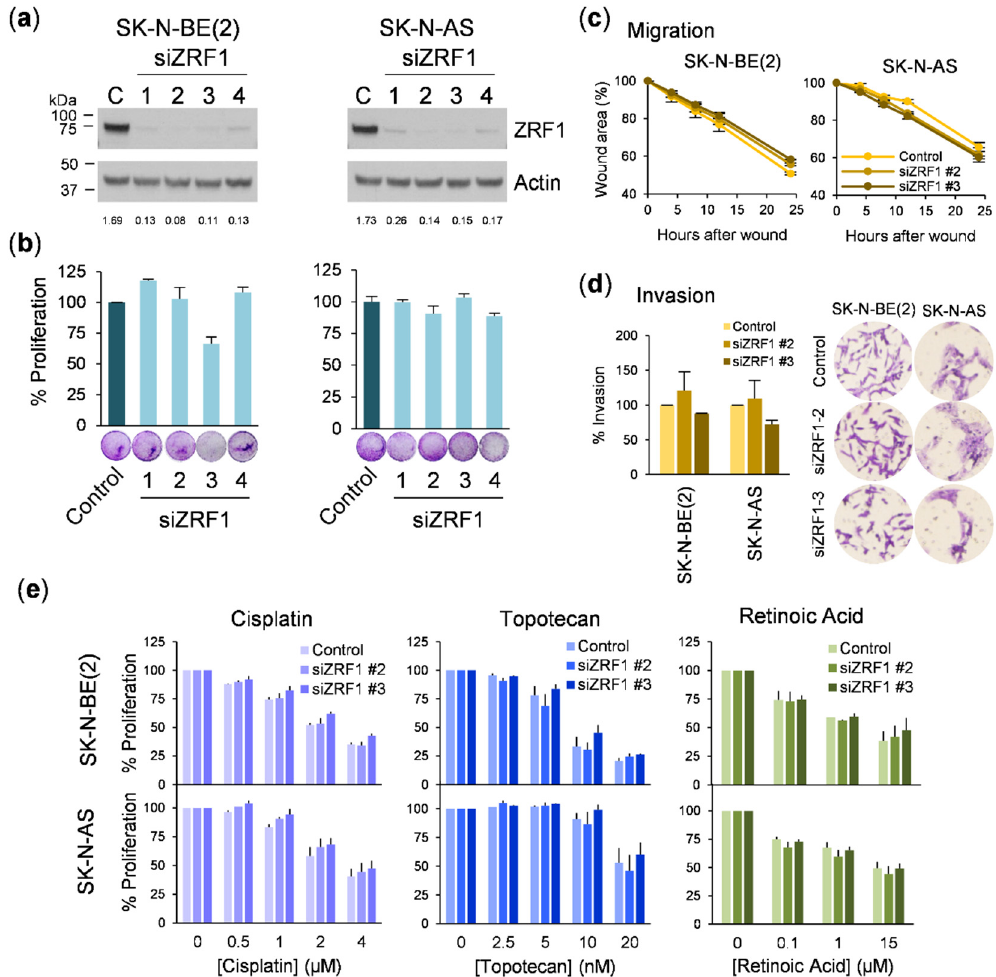
Figure 6. ZRF1 is dispensable for neuroblastoma growth, migration, and drug resistance. ( a ) ZRF1 levels in neuroblastoma cells transfected with siRNA control and 4 different si ZRF1 . Actin-normalized densitometry quantification of ZRF1 levels is shown beneath their respective ZRF1 knockdown validation Western blot panels ( b ) Cell viability assay in neuroblastoma cells transfected comparing siControl vs si ZRF1 at 96h post-transfection. ( c ) Wound-healing assay in si ZRF1 transfected neuroblastoma cells at 72 h post-transfection. ( d ) Invasion assay through a collagen barrier of si ZRF1 transfected cells at 72 h post-transfection. Left, crystal violet quantification of invaded cells. Right, representative images of the invasion assay. ( e ) Cisplatin (left), topotecan (middle), and retinoic acid (right) resistance assay of si ZRF1 -transfected cell lines. Cells were treated after 72 h of transfection at the indicated doses for 72 h more and proliferation was assessed by crystal violet staining.